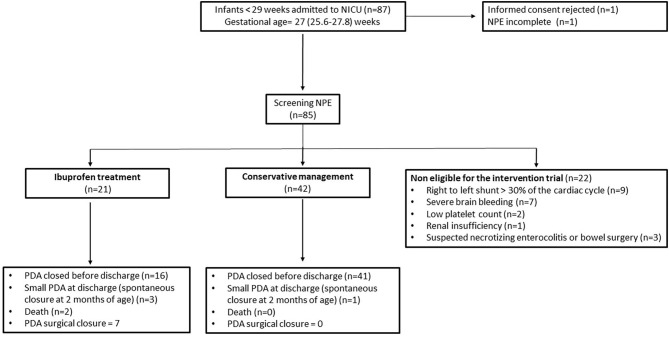
Patient flowchart.